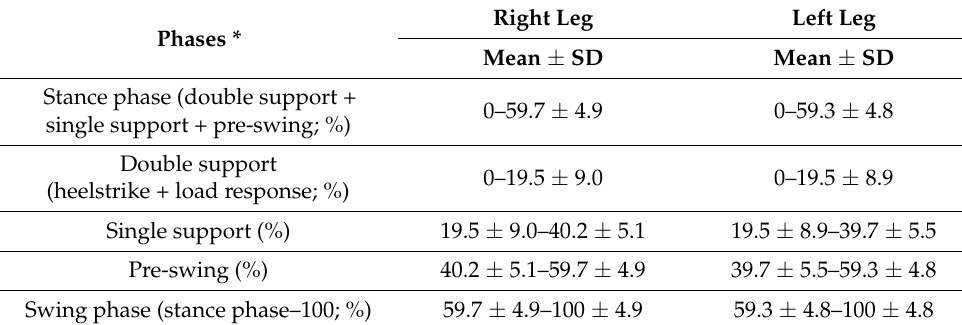
Table 4. Ranges of phases in one gait cycle.